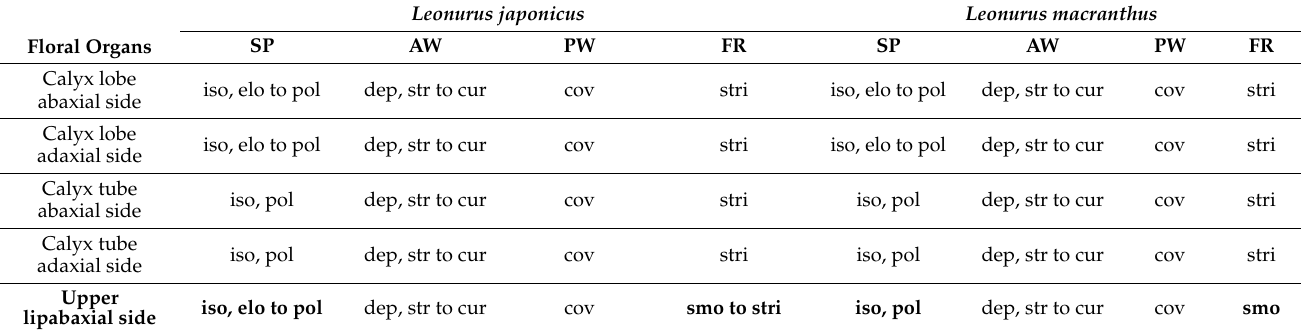
Table 1. Details of the floral epidermal cell surface ornamentation in the two Leonurus